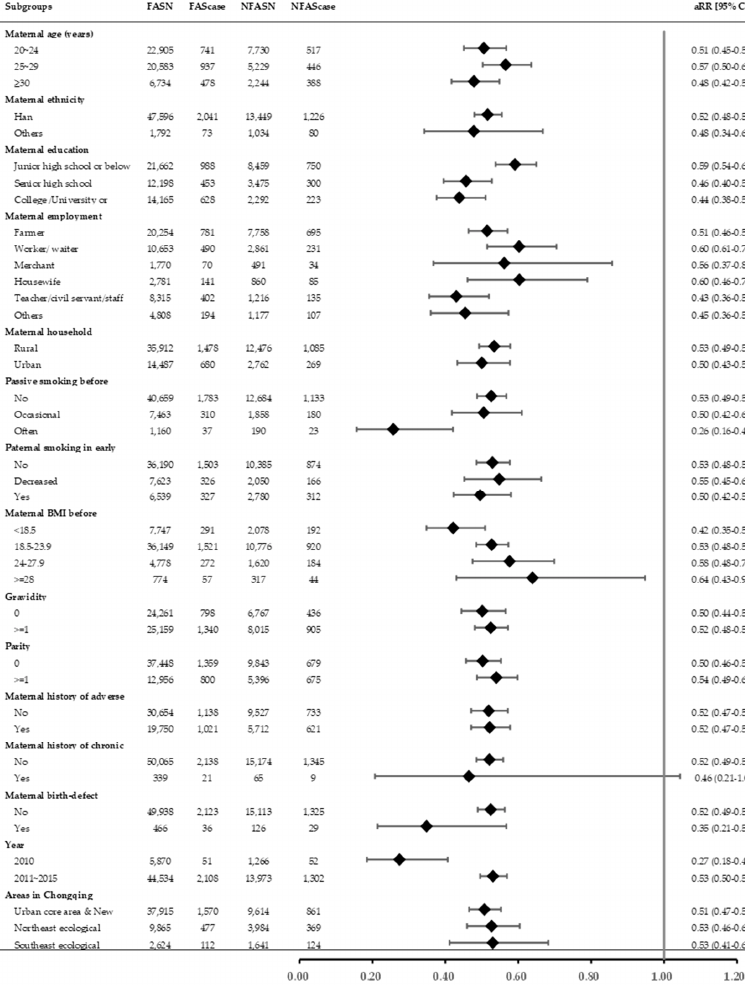
Figure 1. Stratification analyses on the association between folic acid (FA) supplementation and the risk of spontaneous abortion according to maternal characteristics. All risk ratios adjusted for maternal characteristics other than the stratified characteristic. FASN and FAScase: Pregnancy and spontaneous abortion (SA) number, respectively, in the FA group. NFASN and NFAScase: Pregnancy and SA number, respectively, in the no-FA